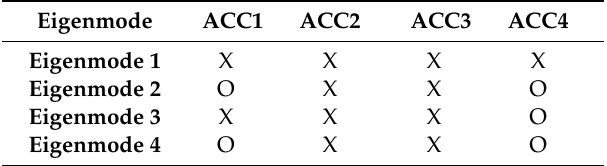
Table 2. Accelerometers and corresponding measured eigenmodes.